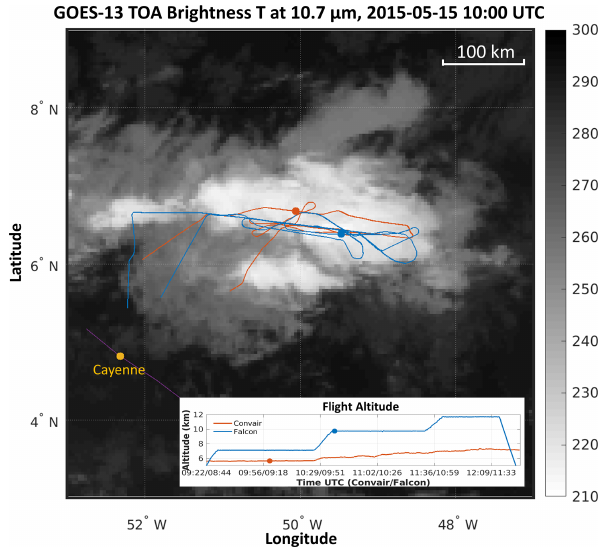
Figure 2. GOES-13 top-of-atmosphere (TOA) brightness tempera- ture at 10.7µm at 10:00UTC on 15 May 2015 (Knapp et al., 2018). Blue lines denote the Falcon 20 flight track and altitudes; red lines denote the Convair 580 flight track and altitudes; red and blue dots indicate the locations and altitudes of the Convair 580 and Falcon 20 aircraft, respectively, at 10:00UTC; and purple line represent the